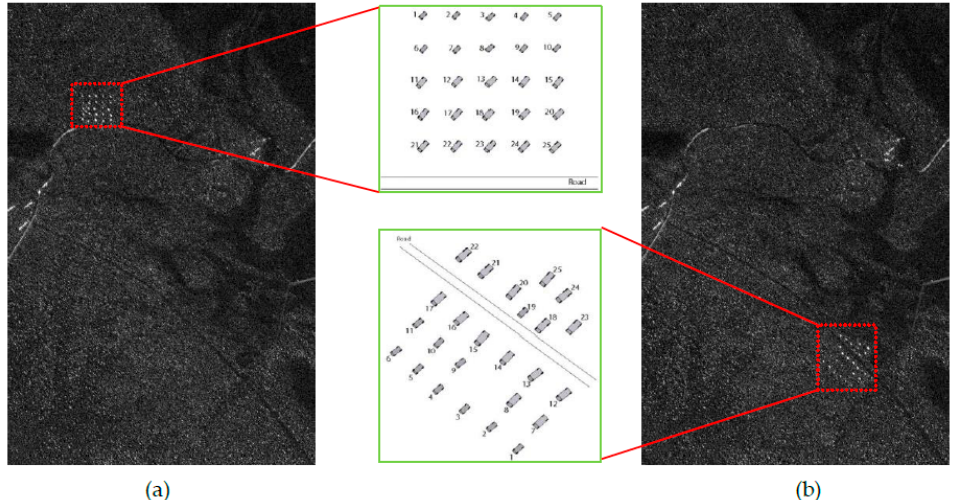
Figure 2. VHF-band synthetic aperture radar (SAR) image pair (vehicles are located in red boxes) used to the first experiment: ( a ) reference image of pass 5 in mission 2; ( b ) test image of pass 5 in mission 4. Note that the sketch of target deployment is also given in this figure.